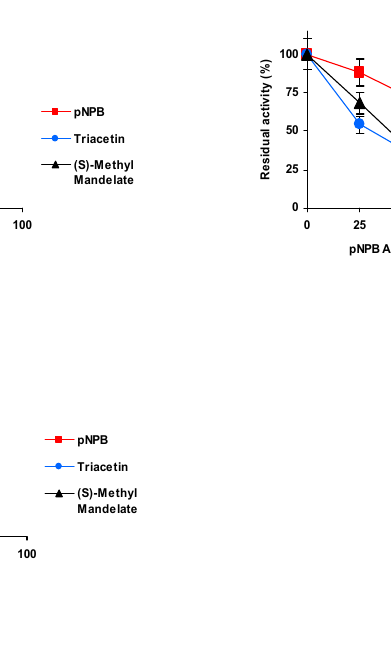
Figure 4. Effect of the inactivation pH on the residual activity versus different substrates of CALB biocatalysts activity blocked with glycine. Inactivation was performed at ( A ) pH 5.0 and 80 °C, ( B ) pH 7.0 and 75 °C and ( C ) pH 9.0 and 60 °C. The substrates used were: p NPB, triacetin, and ( S )-methyl mandelate. Other specifications may be found in Methods section.